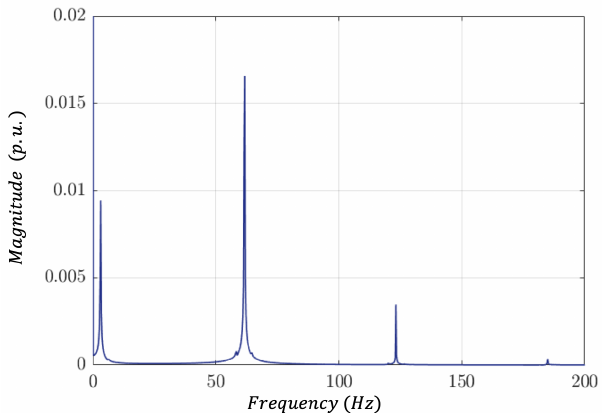
Figure 8. Spectrum of the torus solution.